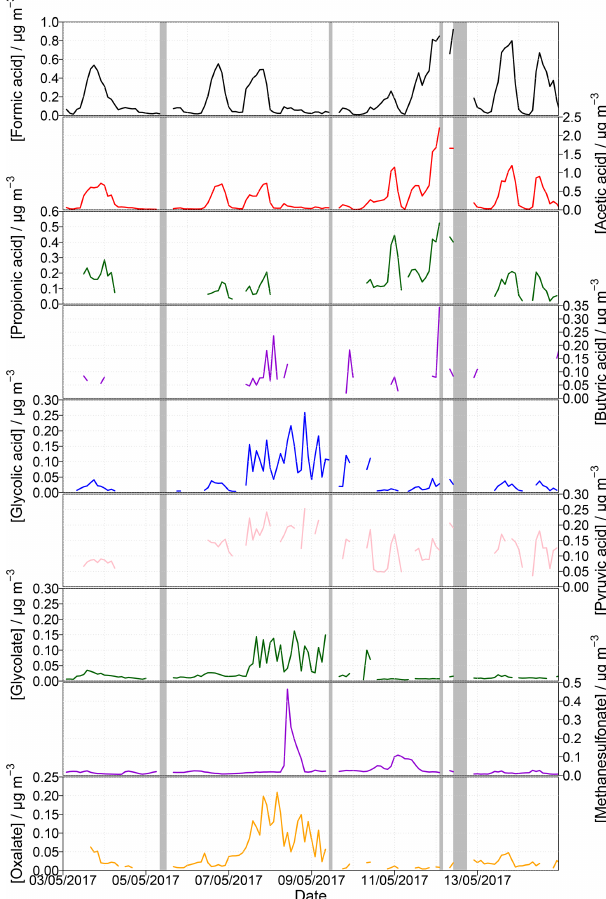
Figure 8. Measured concentrations for gaseous formic, acetic, pro- pionic, butyric, glycolic and pyruvic acid as well as for particulate glycolate, methanesulfonate and oxalate from 3 to 14 May 2017 for an example application. The shaded grey areas represent periods without data because of instrumental